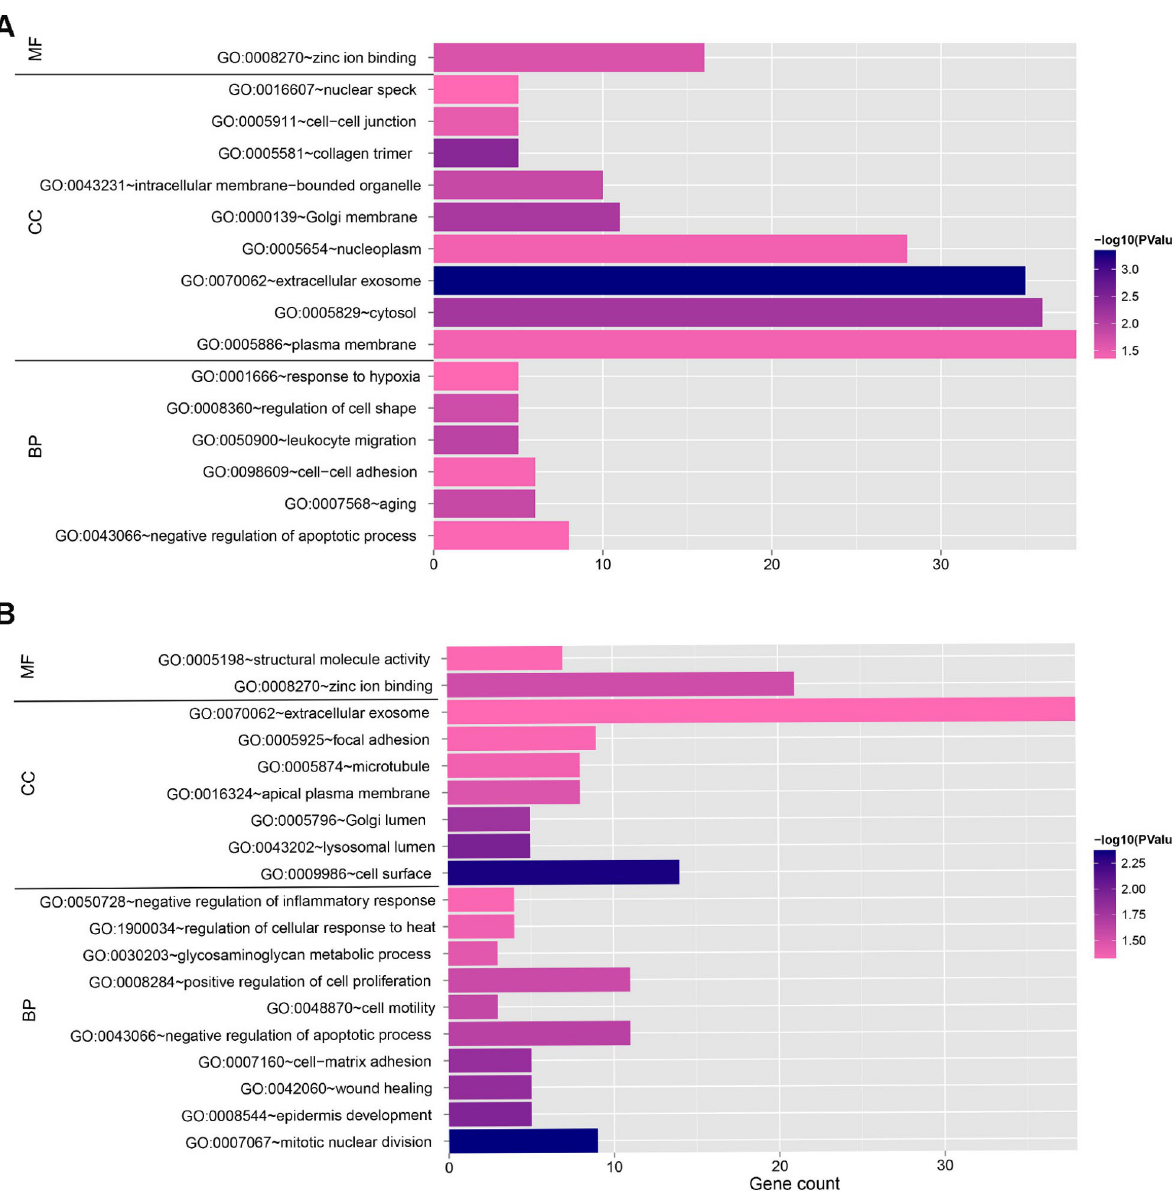
Fig 8. Gene Ontology enrichment analysis of the genes in the ceRNA networks associated with alcohol-related EC. A. The analysis of genes in the blue module. B. The analysis of genes in the turquoise module. The Gene Ontology annotation terms consist of molecular function (MF) annotation terms, cellular component (CC) annotation terms and biological process (BP) annotation terms. The length of column represent gene numbers enriched in this annotation